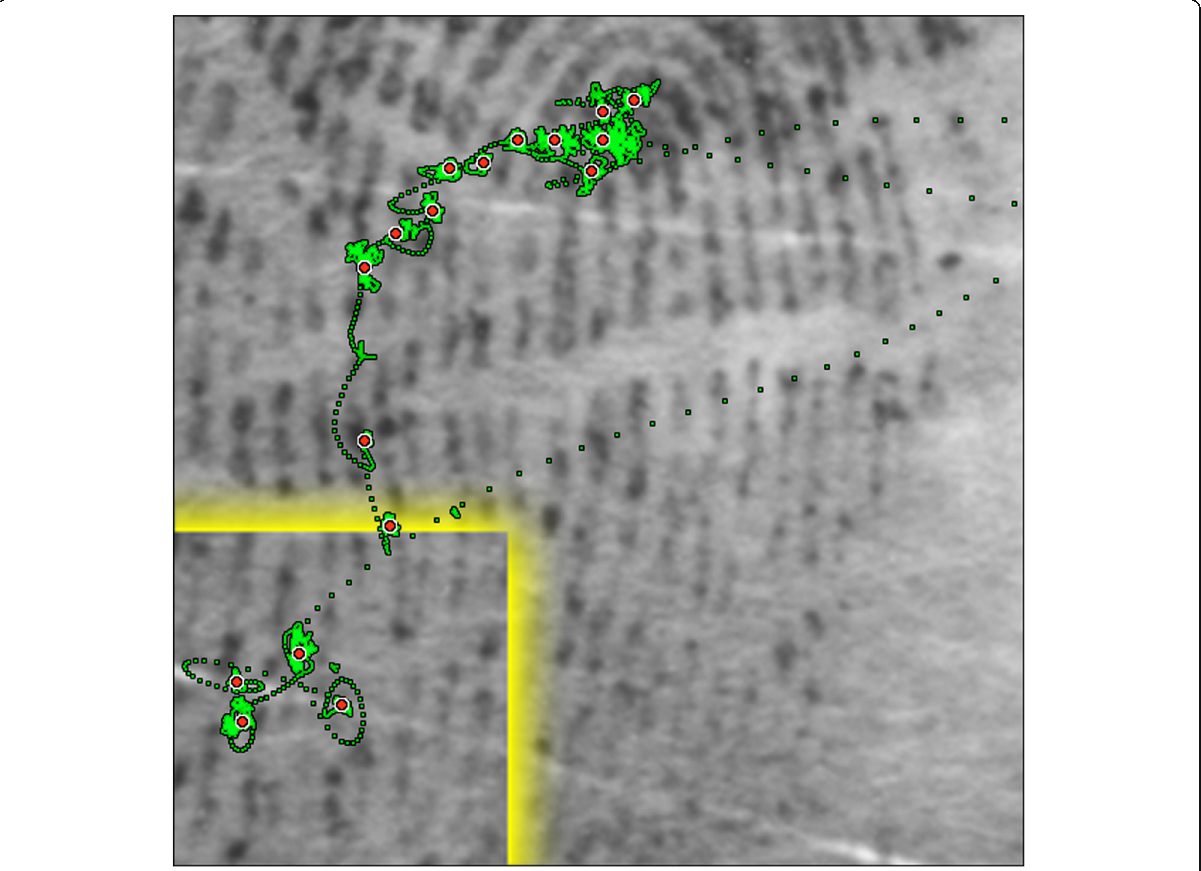
Fig. 3 Example of raw 1-kHz gaze data (green) with fixation centroids (red), from a single examiner. This example shows evidence of what appears to be ridge counting and ridge following behavior as a possible means to relate the target region to the core. The relative closeness of the fixations during counting demonstrates the need for a fixation extraction algorithm that uses two velocity thresholds plus additional temporal and spatial constraints as described in the “ Fixation extraction ” section. A brief pause in the long vertical saccade above the yellow target area was not labeled as a fixation by our extraction algorithm because its duration (50 ms) was less than the 80 ms threshold for a